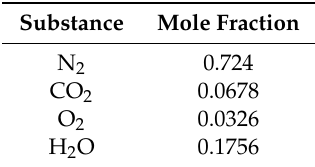
Table 2. Composition of the flue gas stream.